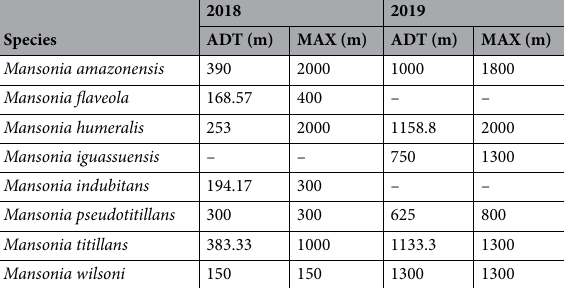
Table 2. Flight distance traveled by marked, released and recaptured Mansonia spp. in the surrounding area of the Amazon Jirau (HPP-Jirau) hydroelectric power plant. (Samplings: 1 to 8). ADT Average distance traveled, MAX Maximum distance